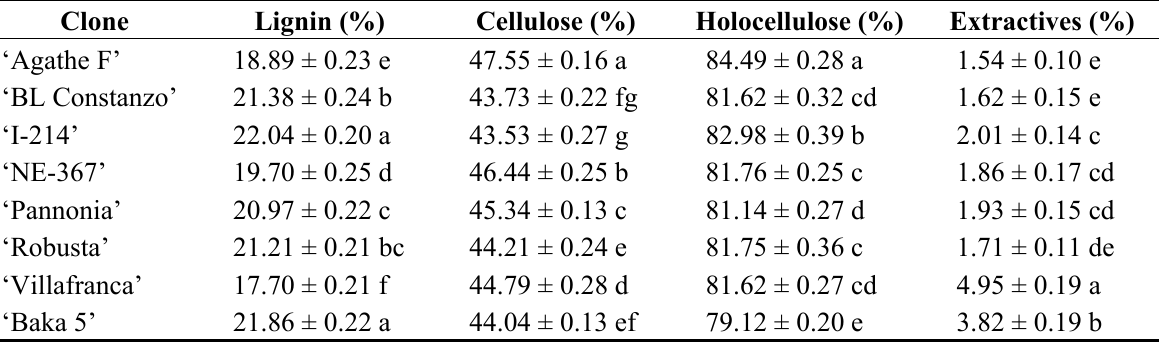
Table 3. The content of main wood components and extractives present in the examined clones of Populus grown on the Gab č íkovo experimental site. Data represent percentages of oven dry weight (odw) (mean ±